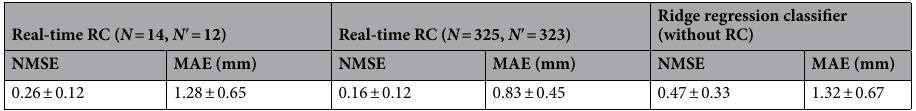
Real-time RC ( N = 14, N ′ = 12) Real-time RC ( N = 325, N ′ =